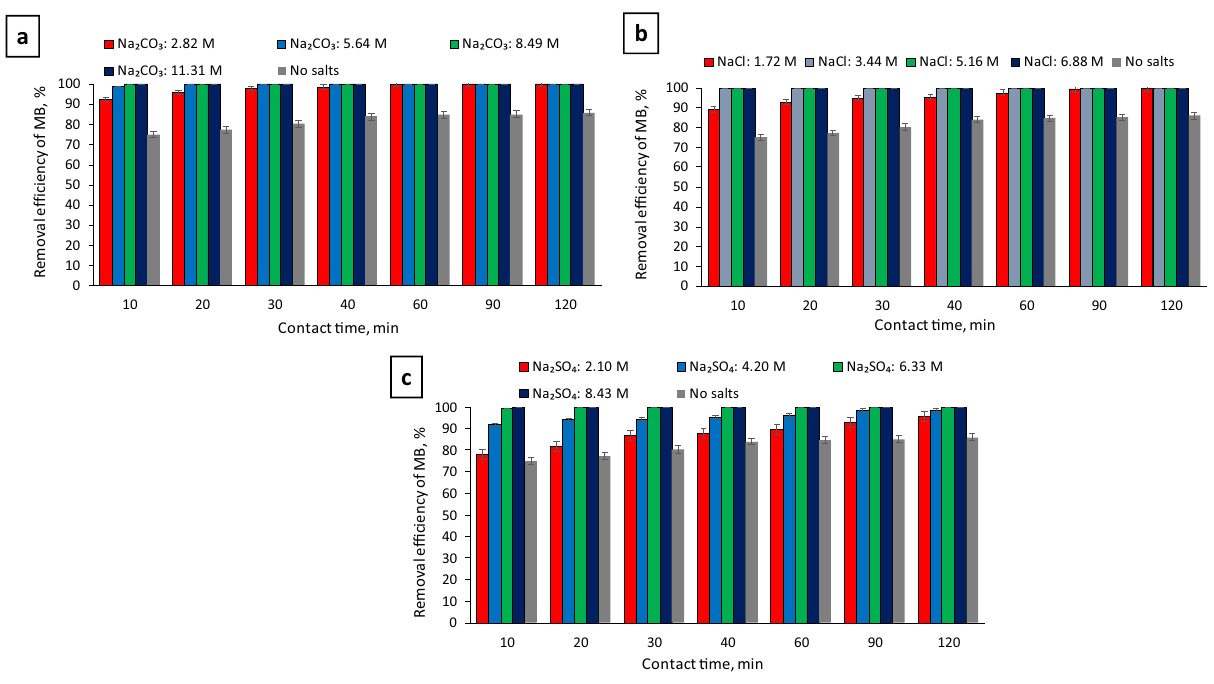
Fig. 5 Effects of adding salts on the removal efficiency of MB by nZVAl at C and temperature 30